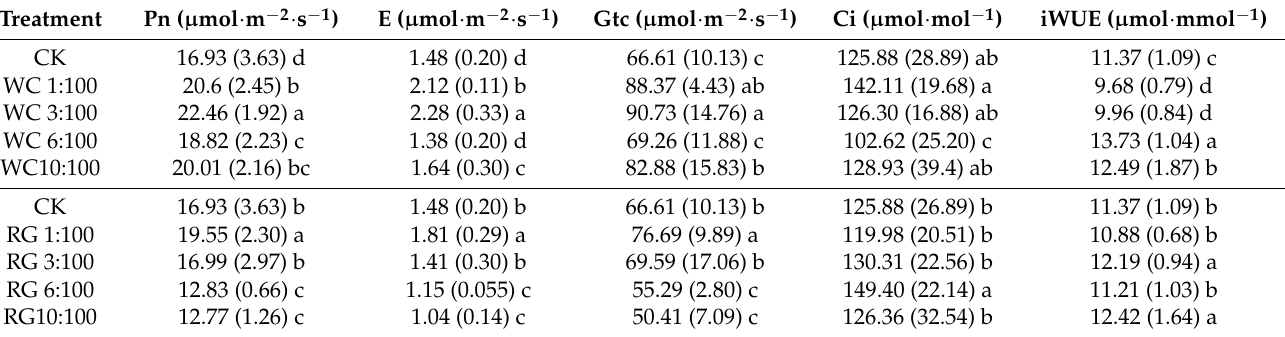
Figure 7. Effect of cover crop turnover on protective enzyme activity and MDA content of corn. ( A – D ) represent related enzyme activities and MDA content in white clover (WC) treatment; ( E – H ) represent related enzyme activities and MDA content in ryegrass (RG) treatment. Different lower-case letters represent significant differences ( p < 0.05) between treatments in RG and WC. The bar represents mean values of 5 replicates ± SD. Table 4. Effect of different soil and straw ratios of WC and RG on corn photosynthesis properties [mean (SD); n =